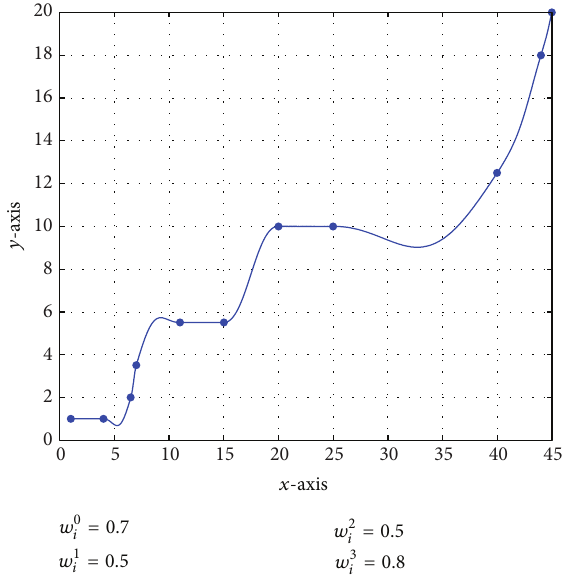
Figure 5: Nonmonotonicity preserving